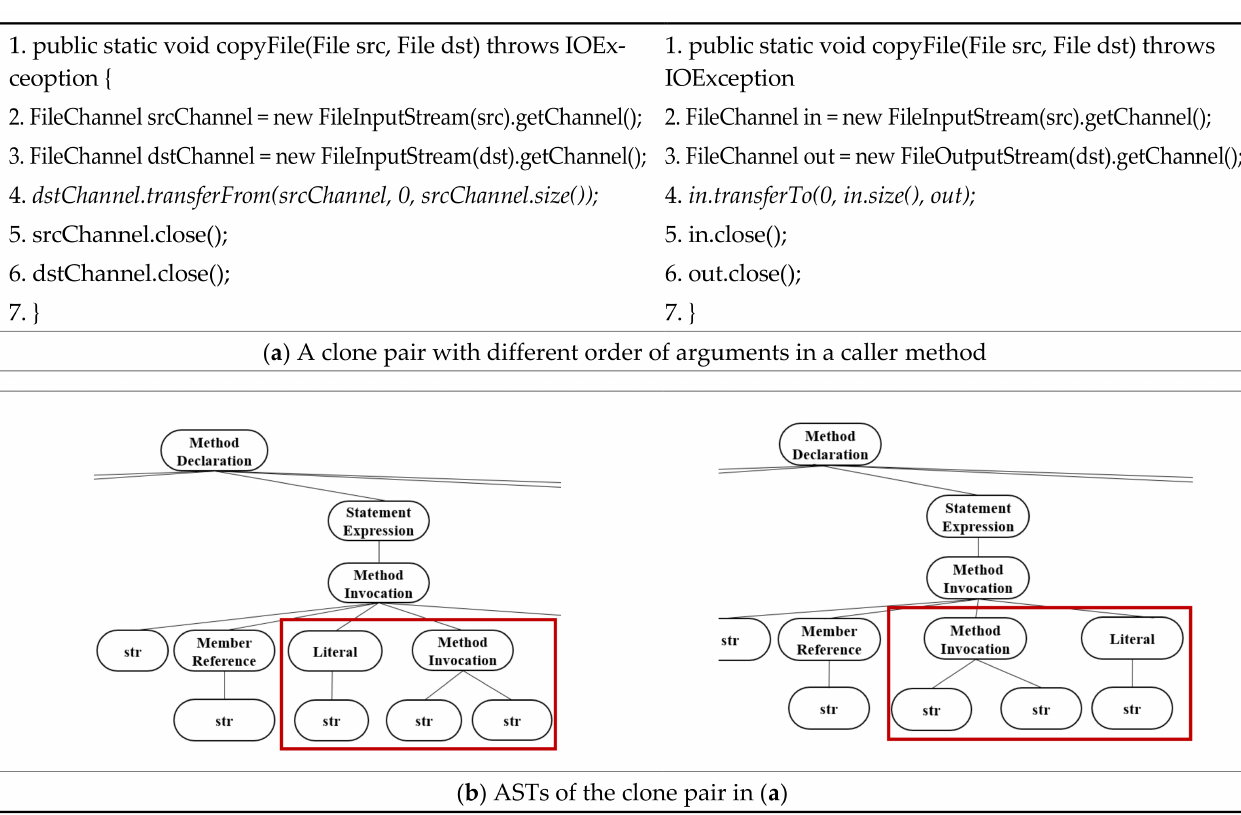
Figure 4. Example of ST3 clone classified as T2